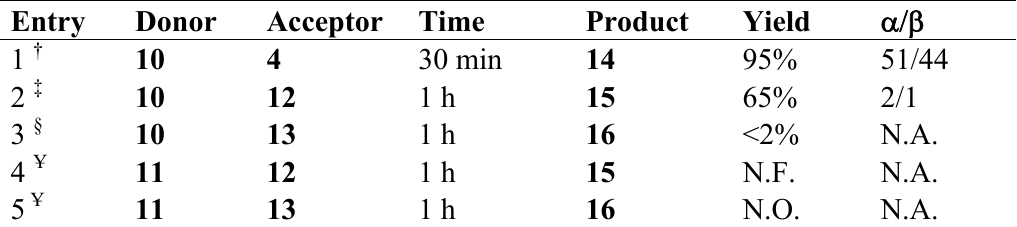
Table 1. Glycosylation between sphingosine analogs 4 , 12 , 13 and 6-azido galactosyl donors 10 , 11 under armed or disarmed